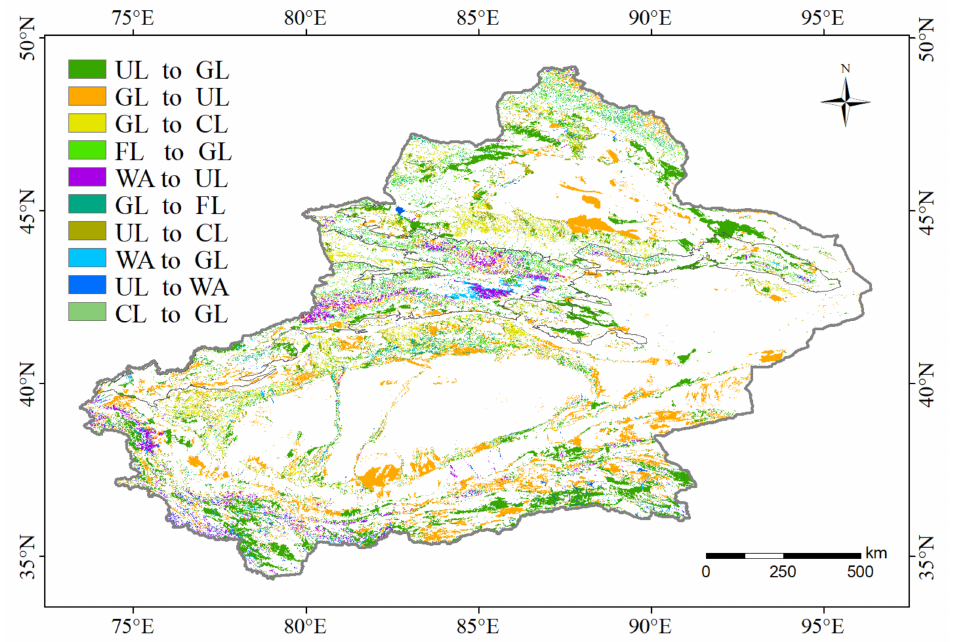
Figure 13. Major land-use changes in Xinjiang during the periods of 2000–2018. UL: unused land; GL: grassland; CL: cultivated land; FL: forest land; BL: built-up land; WA: water